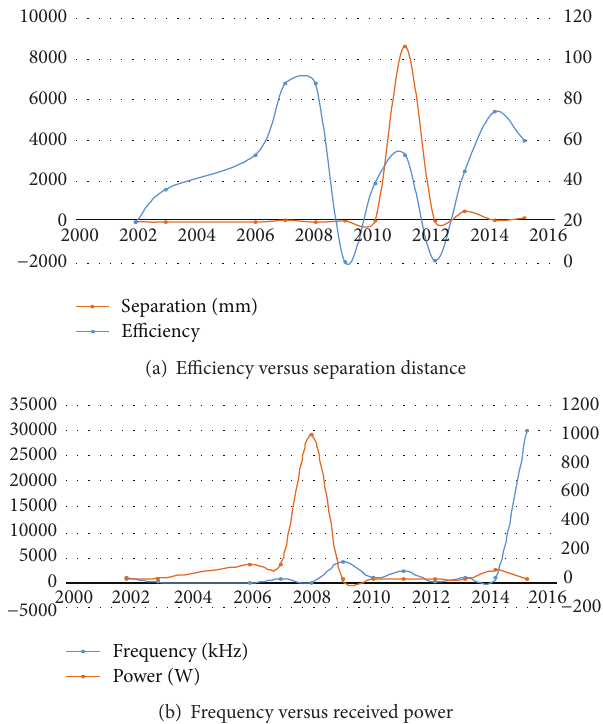
Figure 2: Implemented wall-through AETs. (a) 1 kW energy through metal wall; (b) power delivery setup. Figure 3: Advancements in AET in the context of efficiency, separation distances, frequency, and power in respect to years.